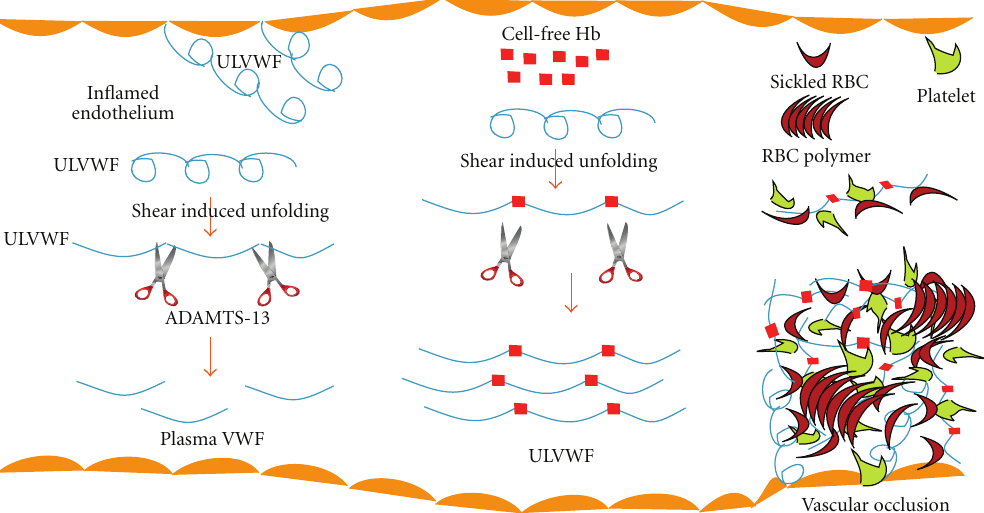
Figure 2: The schematic diagram shows that upon activation of the vascular endothelium, ultralarge VWF is released and is cleaved by ADAMTS13 to smaller fragments that circulate in plasma as an inactive form. Under pathophysiological conditions such as SCA, excessive extracellular Hb blocksthe cleavage of a subpopulation of VWF multimers.The uncleaved Hb-bound VWF multimersaccumulate in plasma, which are hyperactive in binding to platelets or sickled/fragmented-RBCs to promote cell adhesion and events such as thrombosis and vascular